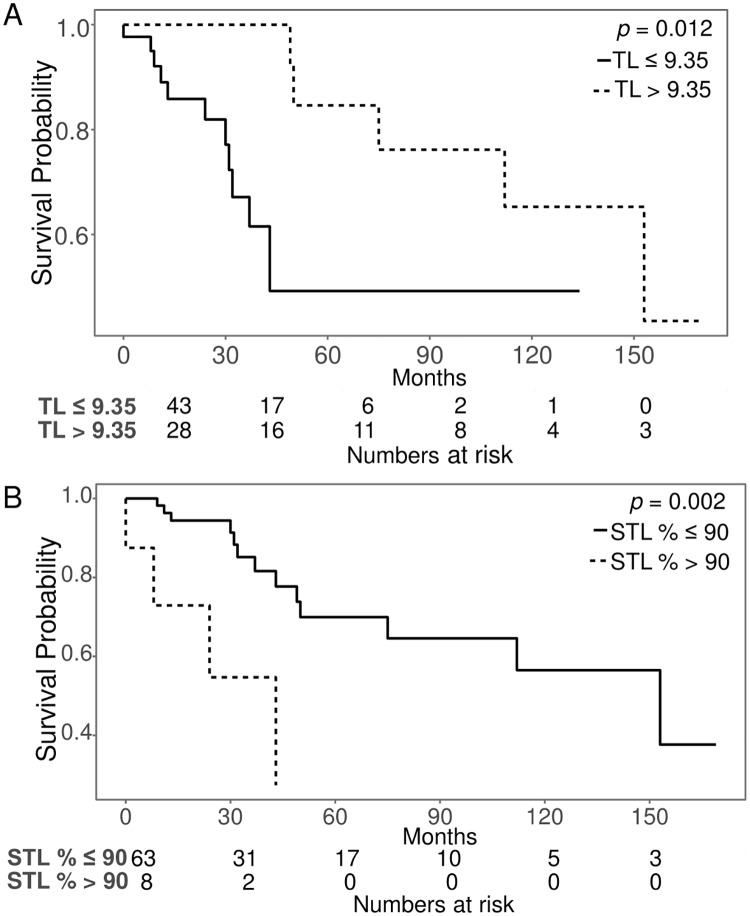
Kaplan-Meier survival curves of TL and the STL%.The overall survival rates changed at a TL of 9.35 and an STL% of 90%.